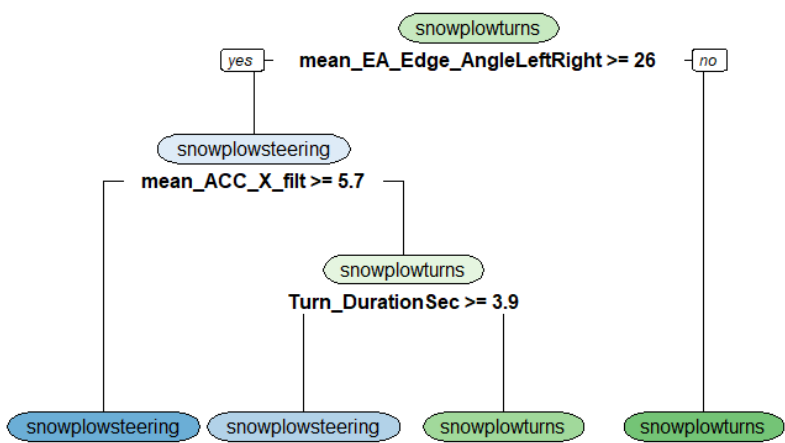
Figure A2. Decision tree for the classification of the parallel turns (max_Speed = maximum speed of turn, sd_TD_AbsRRate_Roll = standard deviation of absolute roll axis angular velocity of turn,